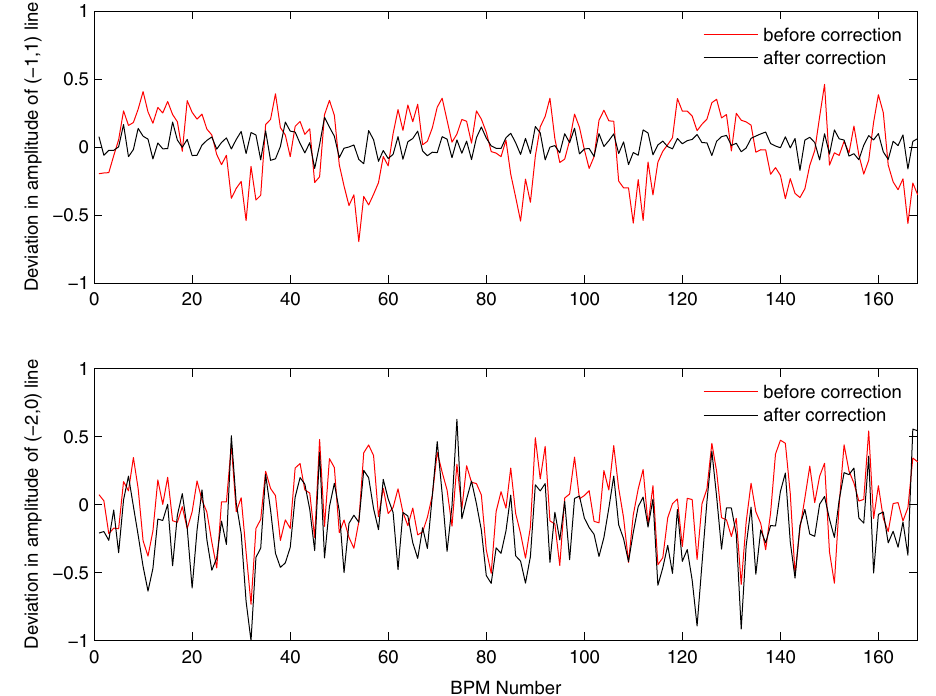
FIG. 7. (Color) Difference of the two spectral lines ð(cid:1) 1 ; 1 Þ and ð(cid:1) 2 ; 0 Þ at the beginning and at the end of the fit procedure (targeting only one